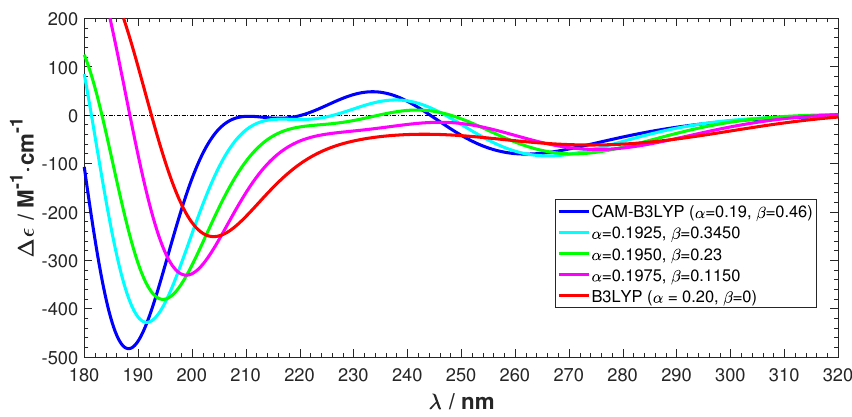
Figure 8. ECD spectra transformation from CAM-B3LYP/maug-cc-pvdz to B3LYP/maug-cc-pvdz.